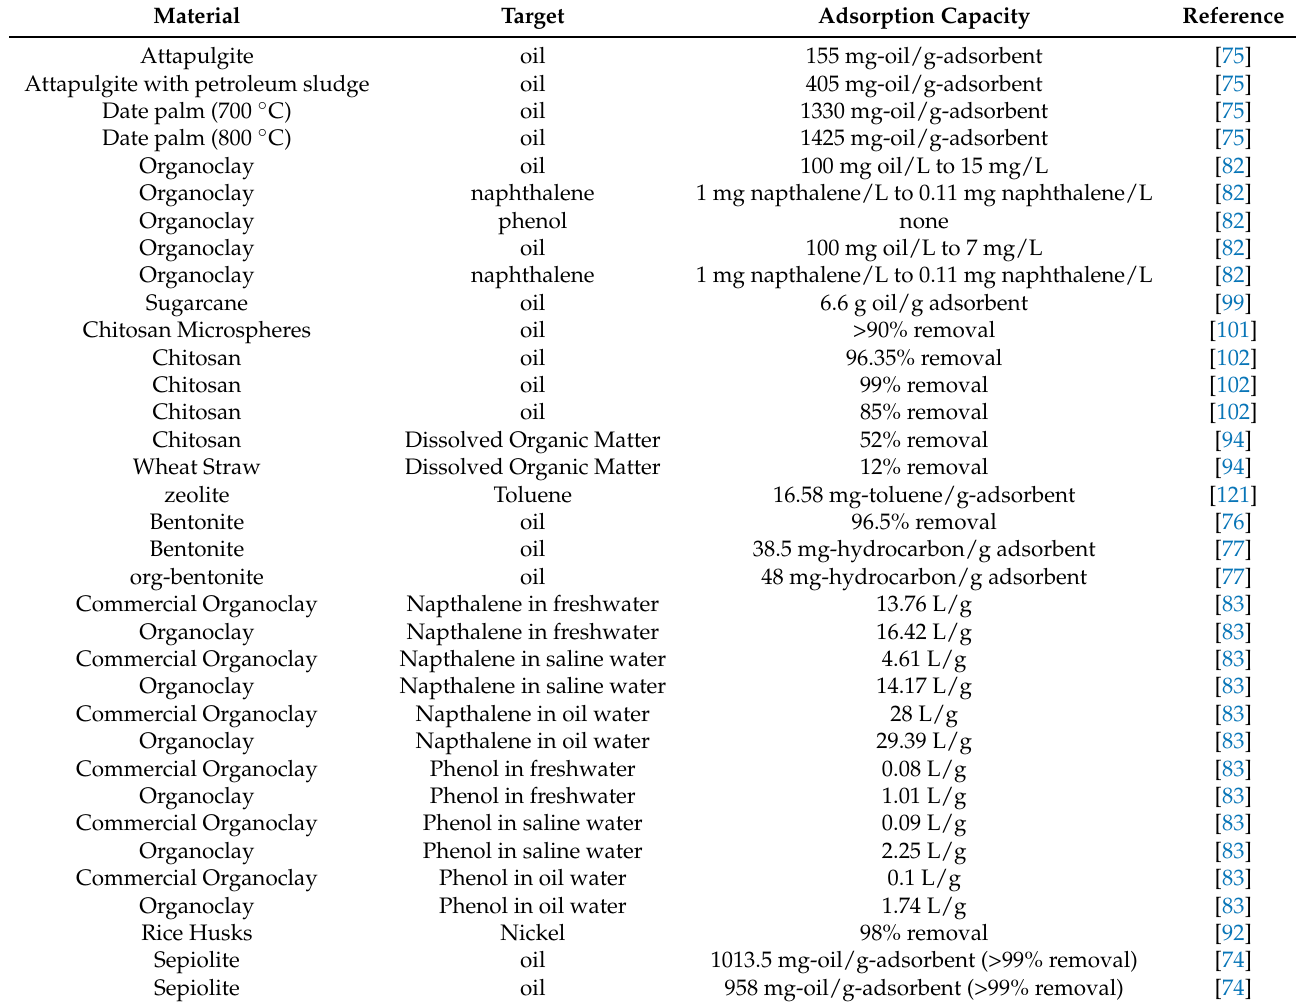
Table 5. Natural adsorbents discussed in this